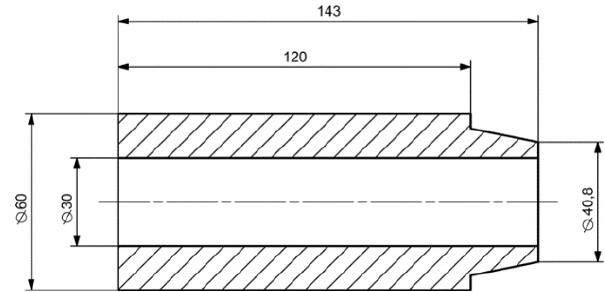
Figure 3. Geometry of MR Element 3.